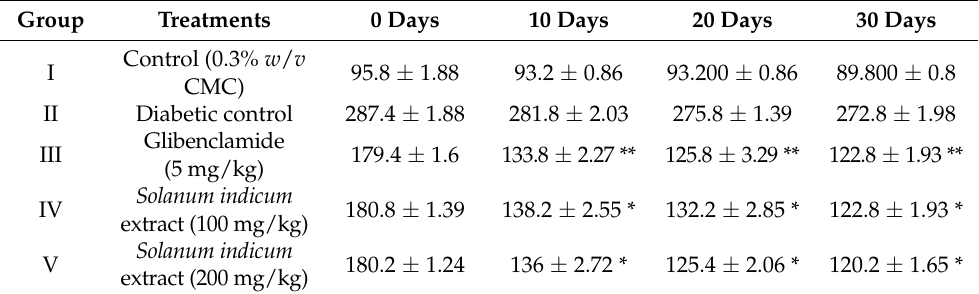
Table 4. Effect of the extract of Solanum indicum fruits on serum glucose in STZ-induced diabetic rats. Group